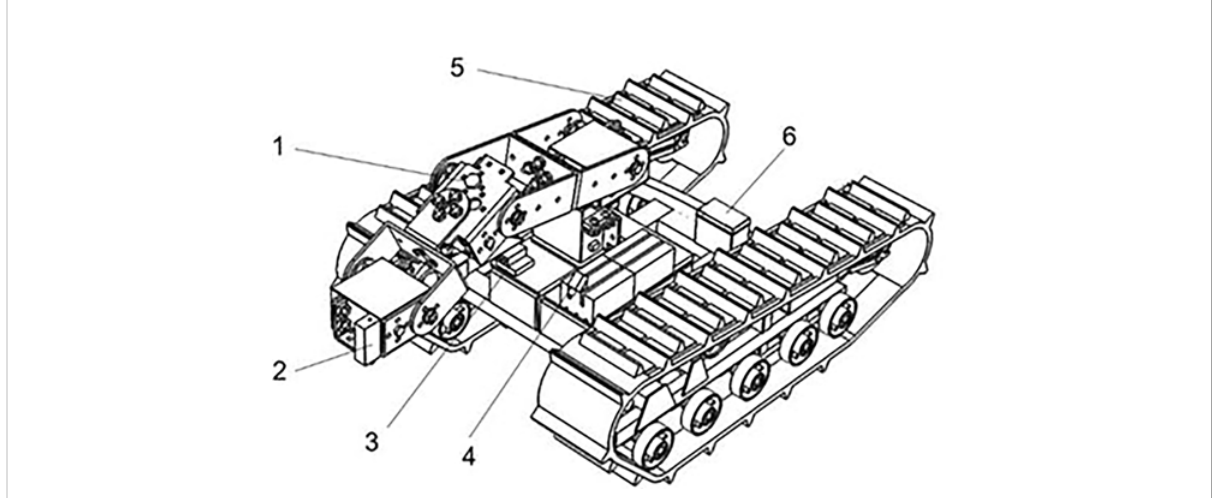
FIGURE 2 Laser weeding robot. 1. Mechanical arm adjustment mechanism; 2. Blue laser emitter; 3. Line road camera; 4. Identi fi cation camera; 5. Crawler mobile chassis; 6. Battery